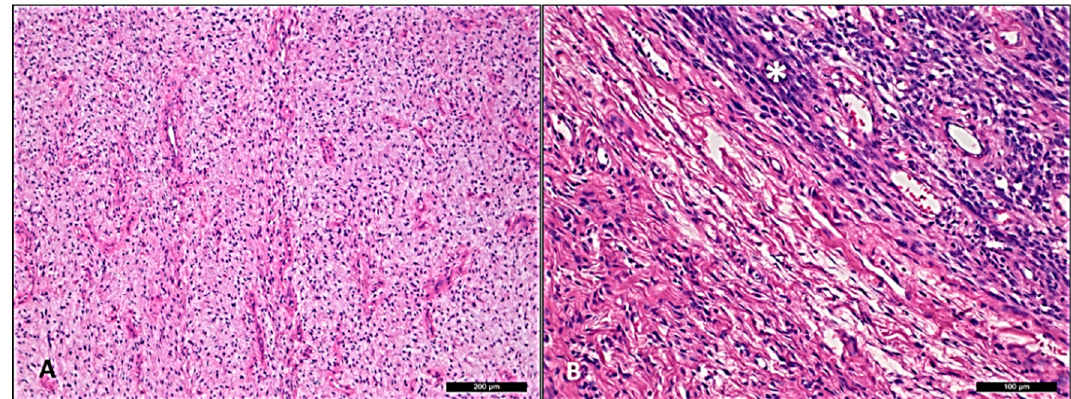
Figure 1. Atypical cellular angiofibroma with scattered atypical cells possessing hyperchromatic nuclei (case 5). ( A ) Area of usual cellular angiofibroma with bland spindle cell component with hyalinized vascular component in fibrotic stroma. ( B ) Abrupt transition to an area showing hypercellularity and moderate nuclear atypia labeled as “*”.